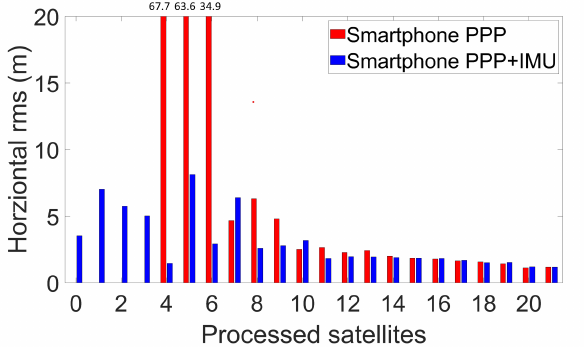
Figure 16. Correlation of the horizontal errors on the number of satellites. Table 12. Statistics of horizontal errors with processed satellites for single- and dual-frequency processing. Processed Satellites per Processing